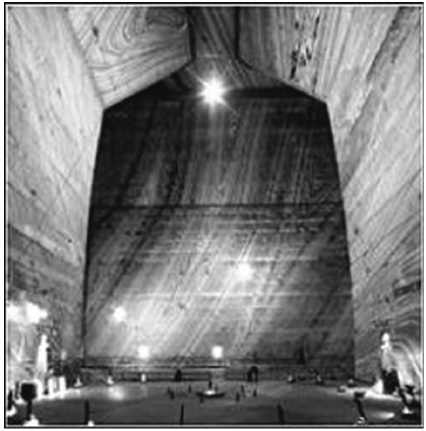
Figure 1: Genesis Room (54m height, 208 m depth) of the “Unirea” salt mine, Slanic Prahova, Romania. Photo courtesy of © Andrei